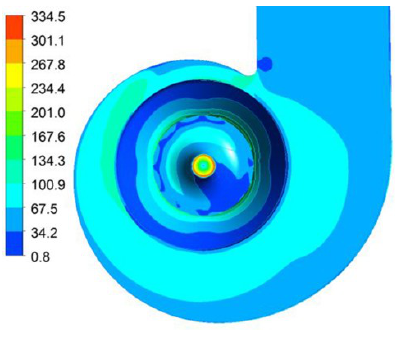
Figure 4. y + of the simulated fan.